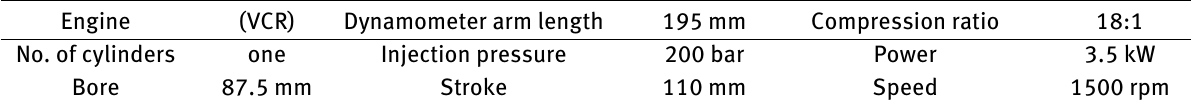
Table 2: The specifications of the test engine